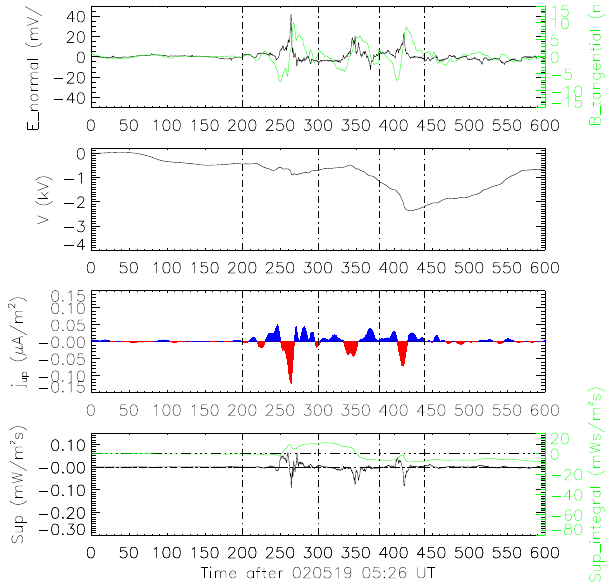
Fig. 4. 19 May 2002, s/c 2. The same panels as in Fig. 2 but without PEACE electron data.